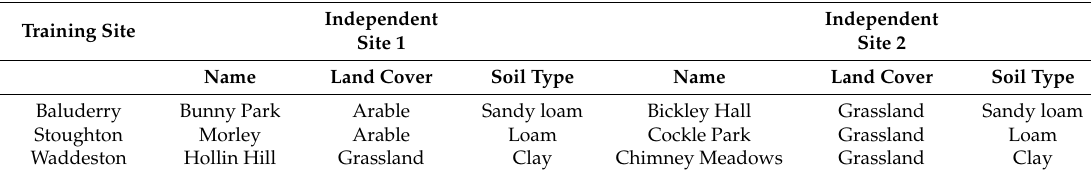
Table 2. The independent sites corresponding to each model training